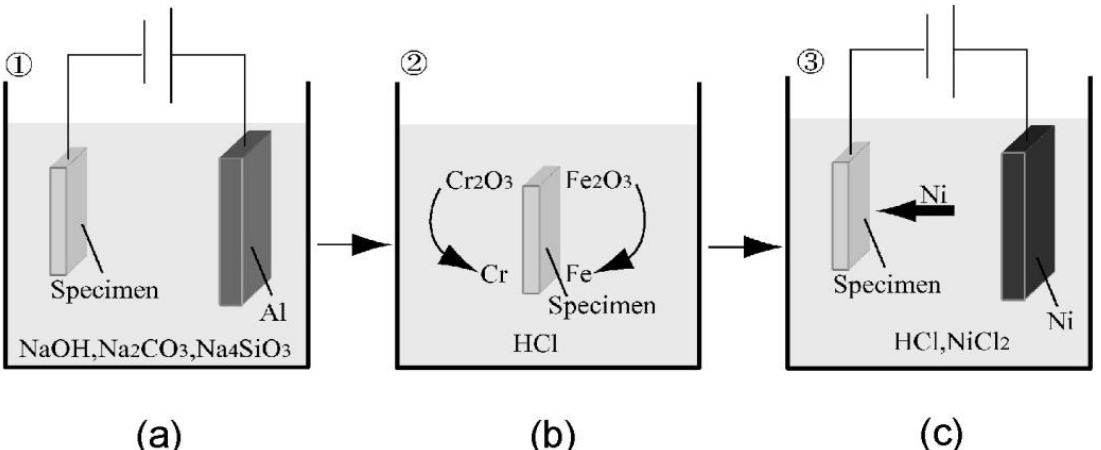
Figure 2. Schematic diagram of the three stages involved in the